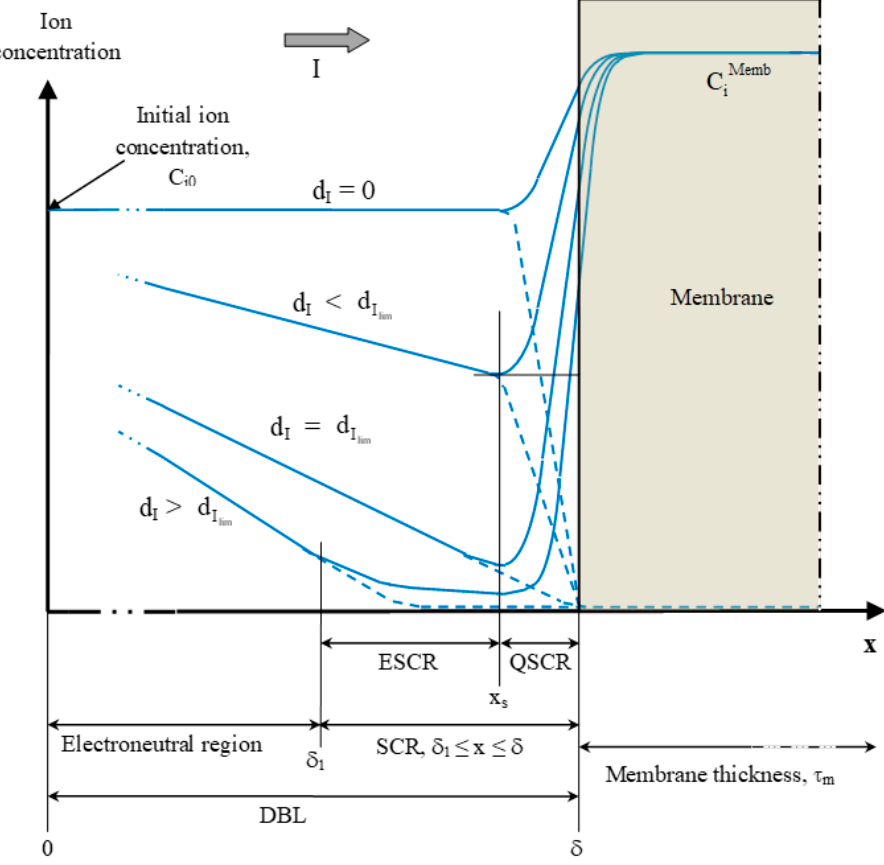
Figure 9. Schematic concentration profiles of counter-ions ( solid line ) and co-ions ( double dashed line ) in the double boundary layer (DBL, thickness δ ) as a function of the current density (d I ) applied. SCR: Space charge region; ESCR: extended space charge region (non-equilibrium part); QSCR: quasi-equilibrium part of SCR (Adapted from Nikonenko et al. [21,51]).